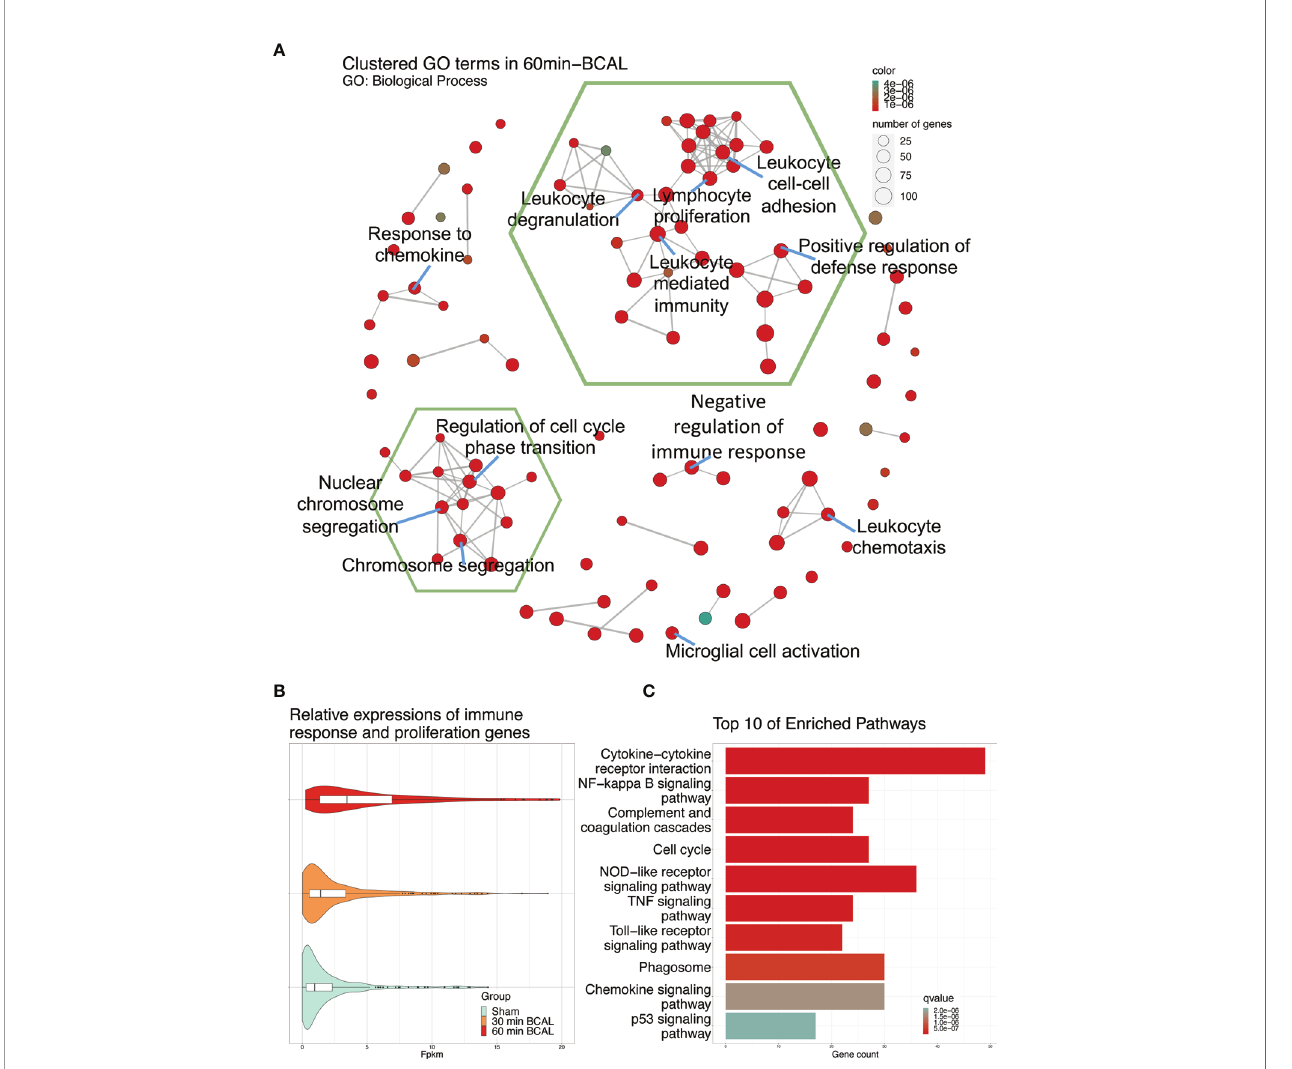
FIGURE 5 | Effect of 60 min of ischemia on the activation of biological processes and signaling pathways. (A) Correlation analysis of the top 100 signi fi cantly enriched GO: Biological Process terms. Terms which share ancestor terms are linked and clustered. The green hexagonal box circles the two largest clusters. The color of the node indicates the signi fi cance of the term, and the size of the node indicates the number of genes in the term. (B) Expression of DEGs in the two largest clusters of GO: Biological Process terms in 60 min BCAL. (C) Top 10 most signi fi cant enriched terms after KEGG enrichment of DEGs in 60 min BCAL. Color indicates the signi fi cance of the